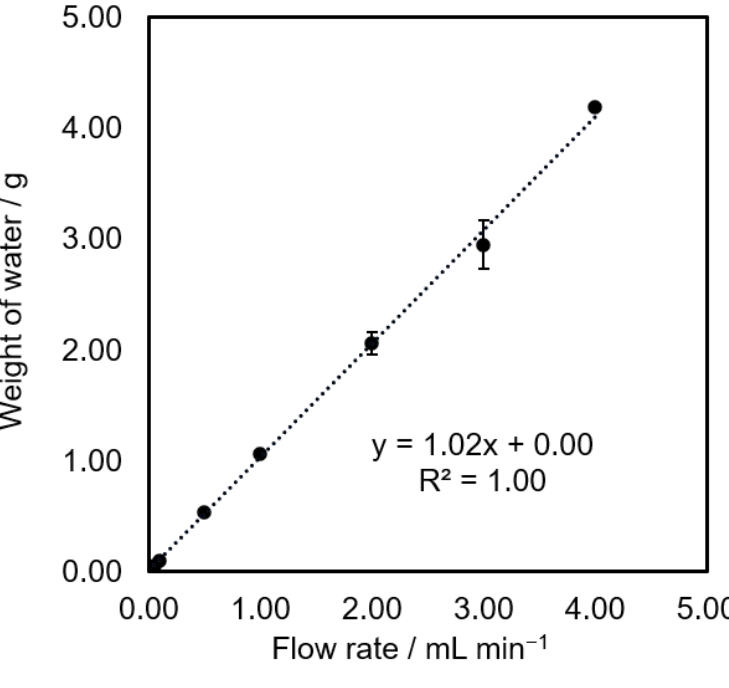
Figure 8. A calibration graph of an in-house syringe pump, n = 3.